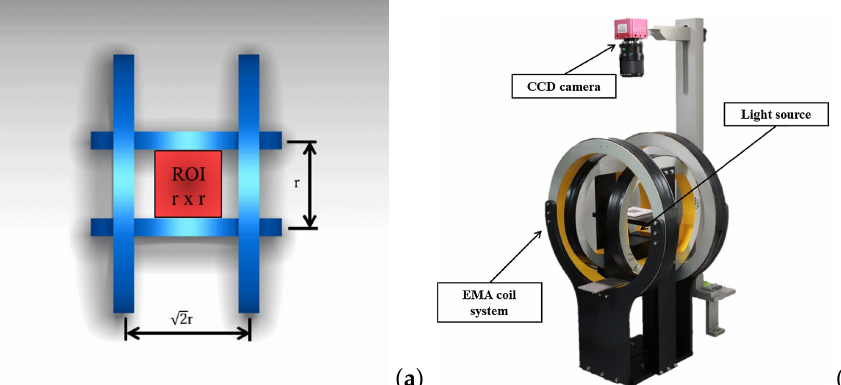
Figure 8. 2C EMA platform developed by Park et al. [70]: ( a ) scheme of the concept; and ( b ) a photograph of the built system.